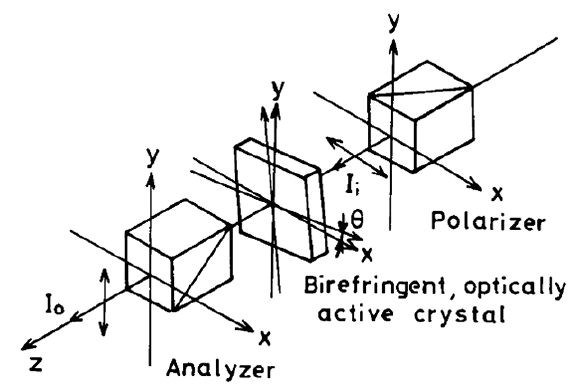
Figure 1. Optical arrangement for measurement of filter